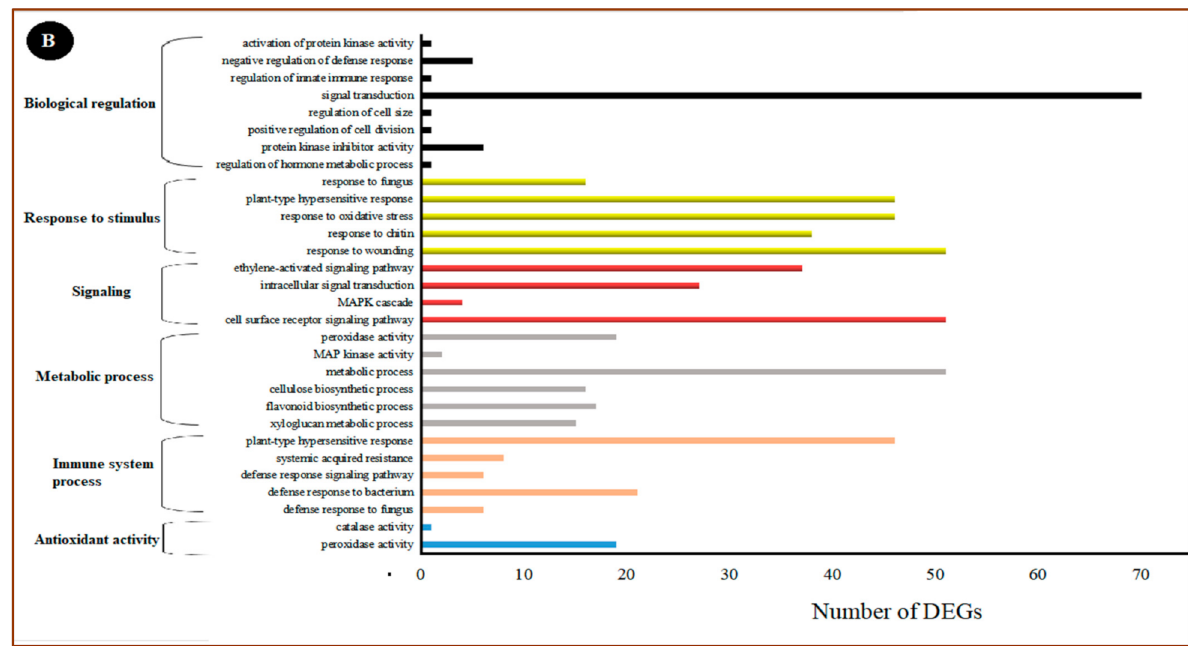
Figure 4. The GO enrichment analysis of significantly enriched DEGs in the RNA-seq result. ( A ) Secondary classification. ( B ) Tertiary